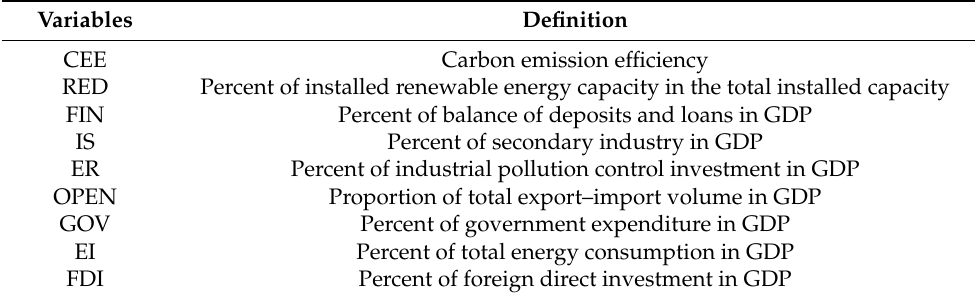
Table 2. Definition of research variables.